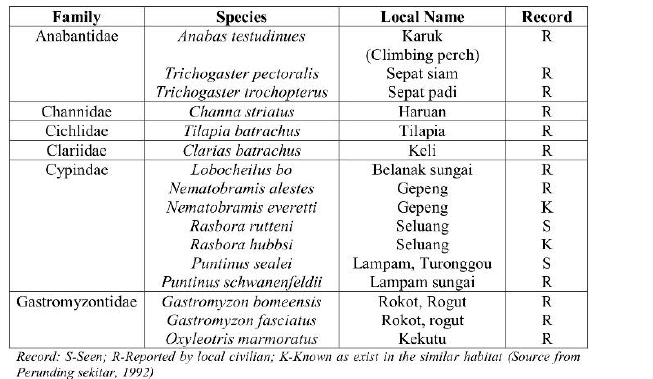
Figure 7: Flesh flood in the study area. A. Trace of water level (arrow) or flash flood in Ho Wah Genting Coach’s guard post at km 26 of Tuaran